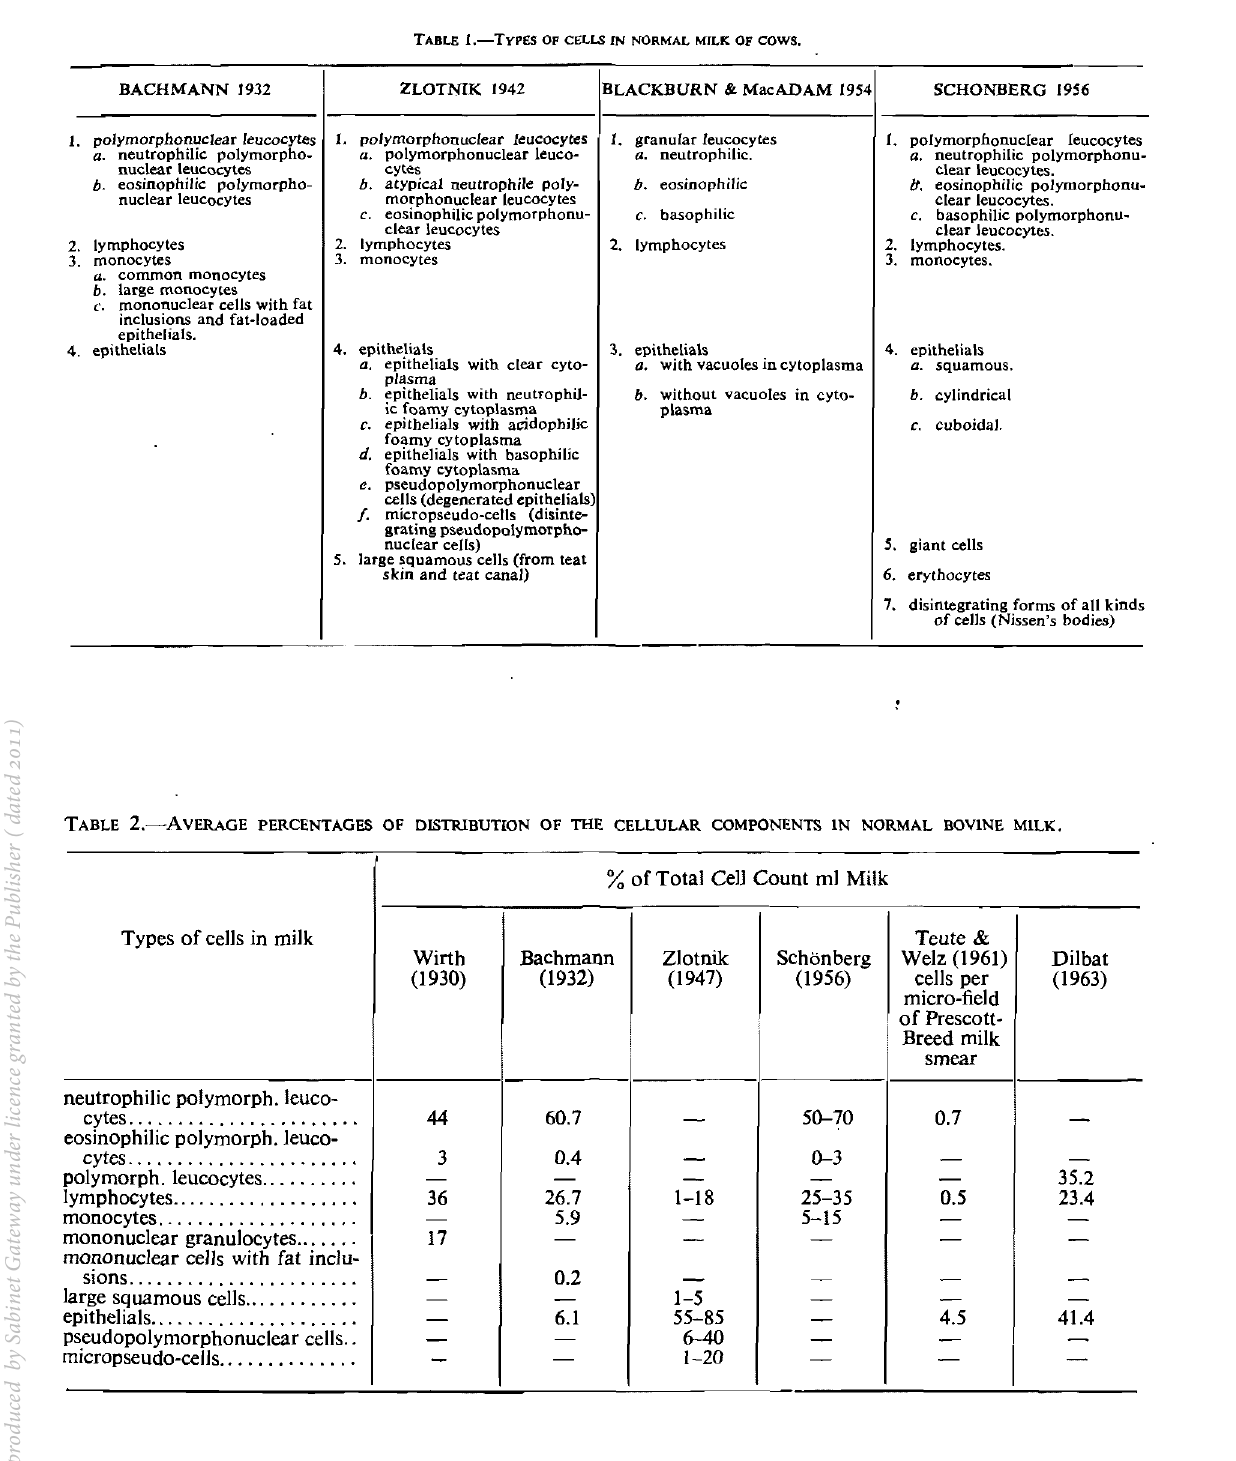
TABLE 2.-AVERAGE PERCENTAGES OF DISTRIBUTION OF THE CELLULAR COMPONENTS IN NORMAL BOVINE